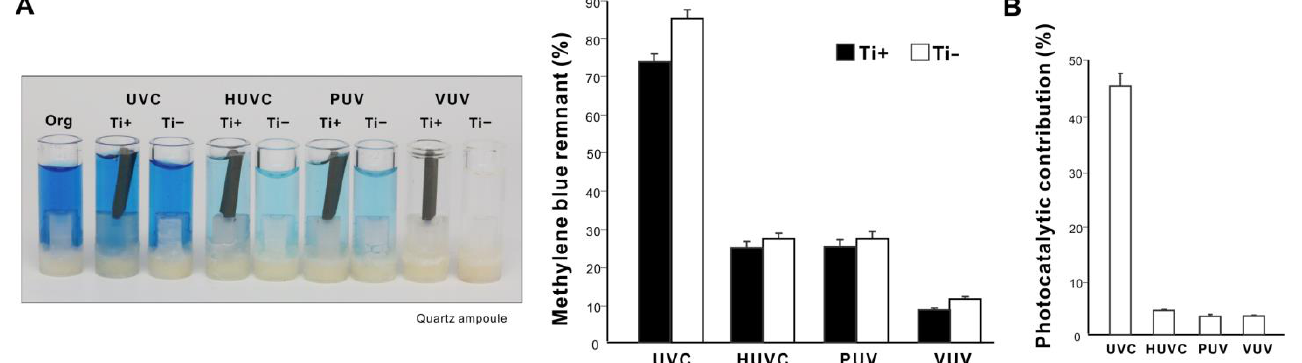
Figure 3. UV - mediated decomposition of methylene blue induced by various UV sources. ( A ) Photographs of the original methylene blue solution in a quartz ampoule together with solutions after UV treatment presented side-by-side for comparison. Four different UV light sources were used for one minute: (1) UVC from a low-pressure mercury lamp (UVC); (2) high-energy UVC (HUVC); (3) a UV device with a proprietary protocol (PUV); and (4) 172 nm vacuum UV (VUV). Methylene blue was UV-treated with or without a microroughened titanium specimen. A histogram showing remnant methylene blue after UV treatment (%). ( B ) Photocatalytic contribution (%) calculated as the difference in the amount of decomposed methylene blue with and without a titanium specimen.